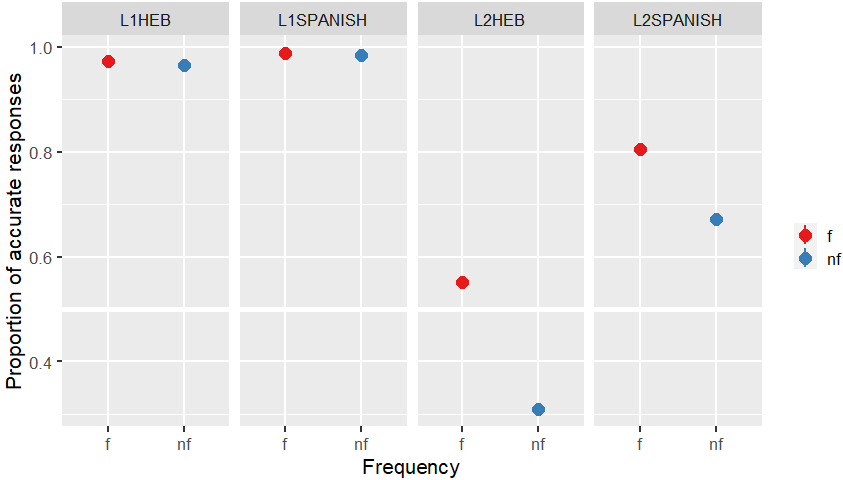
Figure 4. Proportion of accurate responses by frequency condition in FCT task .